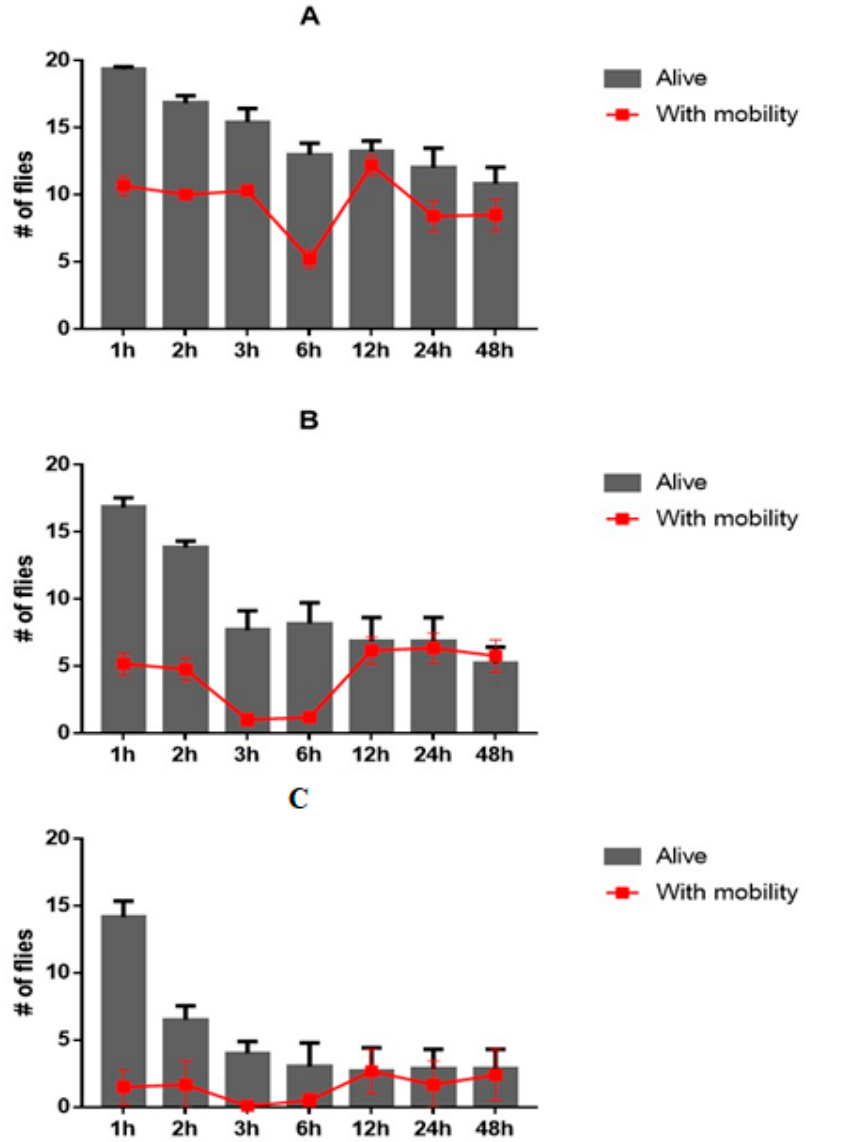
Figure 4. Relation between live flies and changes in mobility. The lines represent the number of flies that reached the top in the time intervals of exposure to benzaldehyde ( A = 1.25 µ g/mL, B = 1.5 µ g/mL, and C = 1.75 µ g/mL) and the histograms represent the number of live flies.